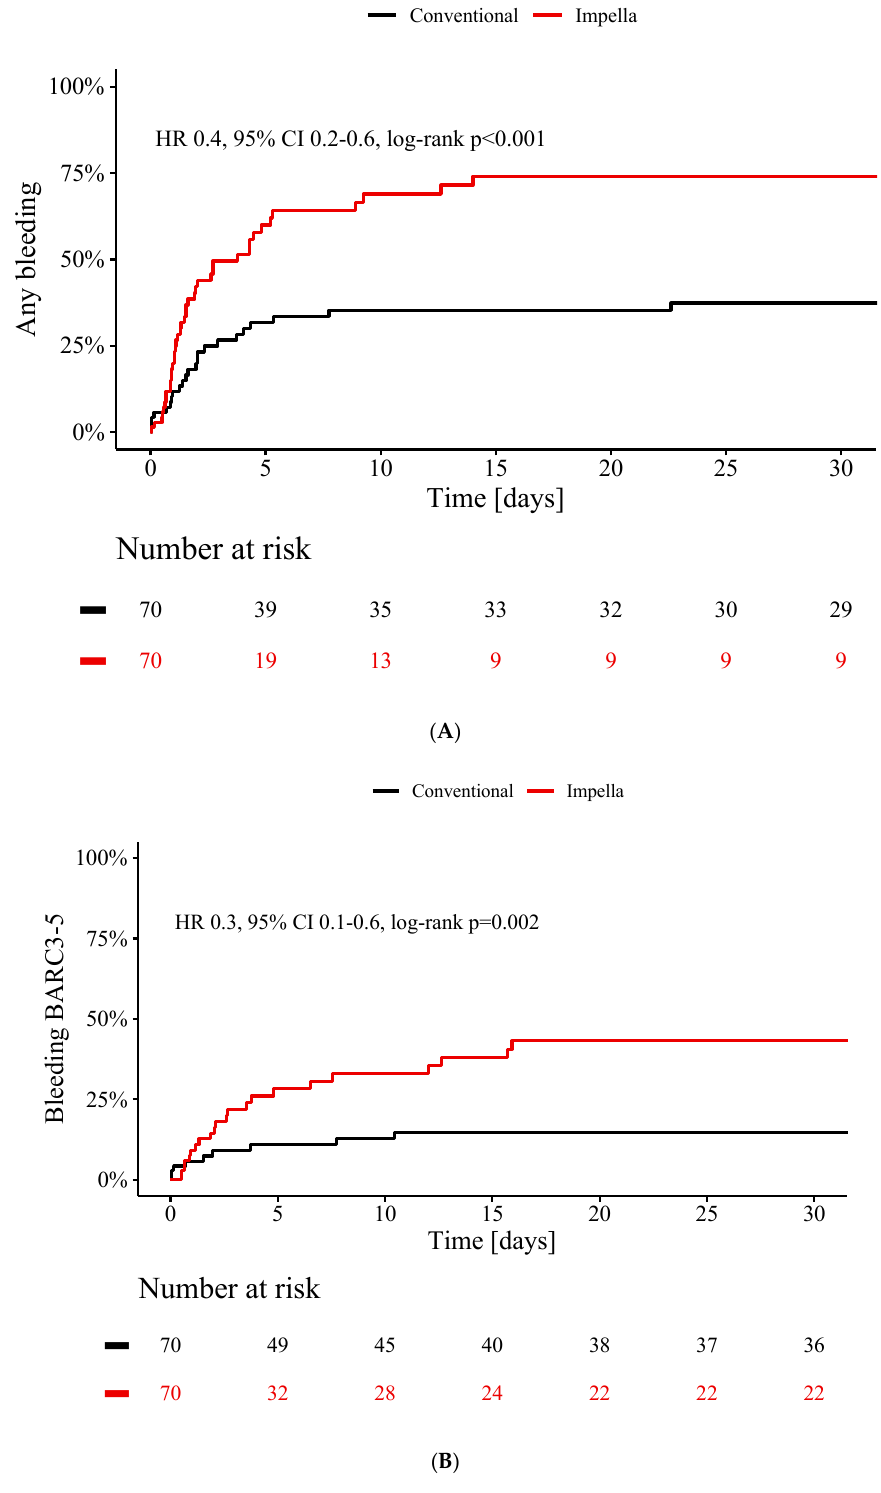
Figure 3. Bleeding complications in patients treated without cardiocirculatory support versus patients treated with Impella CP. ( A ), Cumulative incidence curves of all bleedings occurring in patients without (black) and with Impella CP (red) are shown for 30 days after the index event. ( B ), Cumulative incidence curves of bleeding complications at least classified as BARC3 occurring in patients without (black) and with Impella CP (red) are shown for 30 days after the index event. HR and 95% CI is displayed for conventional